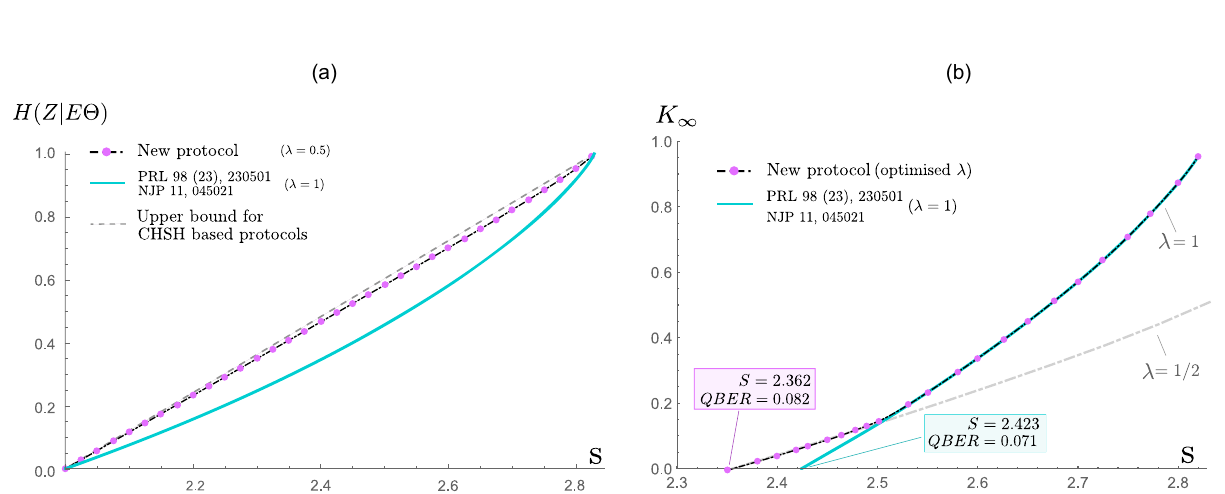
Fig. 2 Secret key rate and uncertainty of Eve. a Assuming the validity of quantum theory and a given CHSH value S > 2, we show that our new protocol can establish and certify drastically more uncertainty H ( Z ∣ E Θ ) (close to the upper physical limit) than the best approach known before. b We consider a noise model (depolarising noise) 2,3 that only depends on the CHSH value S . Now a larger amount of noise can be tolerated in order to establish a positive key rate K ∞ . In detail, we can decrease the critical CHSH value from 2.423 to 2.362. This corresponds to an increase of the critical bit-error-rate from 0.071 to 0.082, which brings a practical implementation of DIQKD into the reach of existing